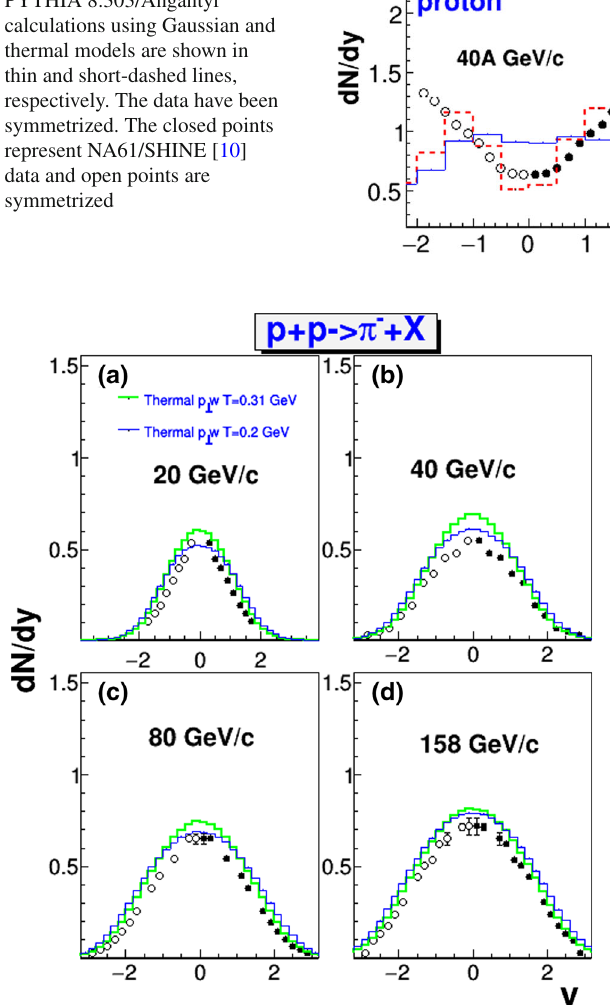
Fig. 4 Rapidity distributions of π − in pp collisions in comparison to PYTHIA 8.303 calculations with different temperatures (T). The closed points represent NA61/SHINE [10] data and open points are